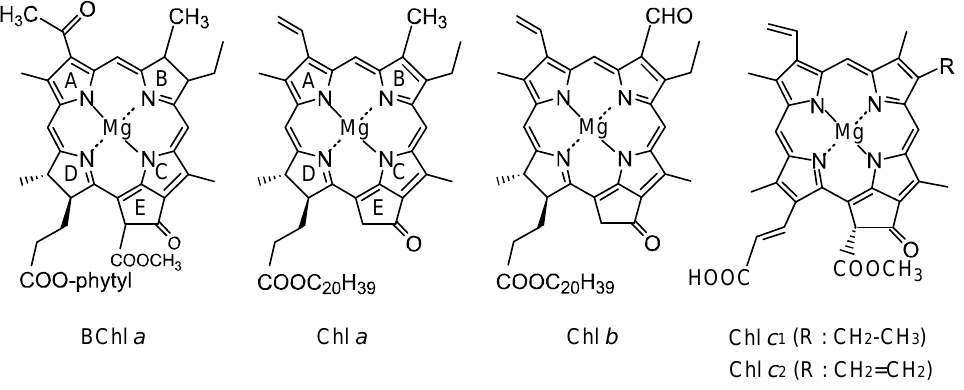
Figure 2. Chemical structures of BChl a having the bacteriochlorin skeleton, Chl a and Chl b having the chlorin skeleton, and Chl c